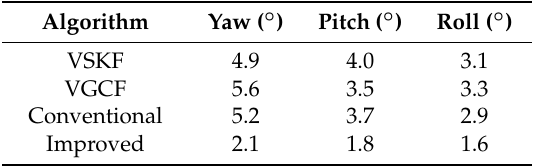
Table 2. RMS errors of the yaw and attitude